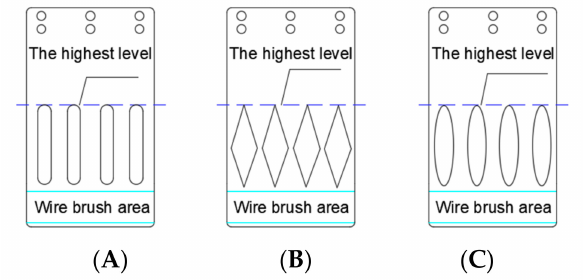
Figure 10. Three different brush plate groove shapes.